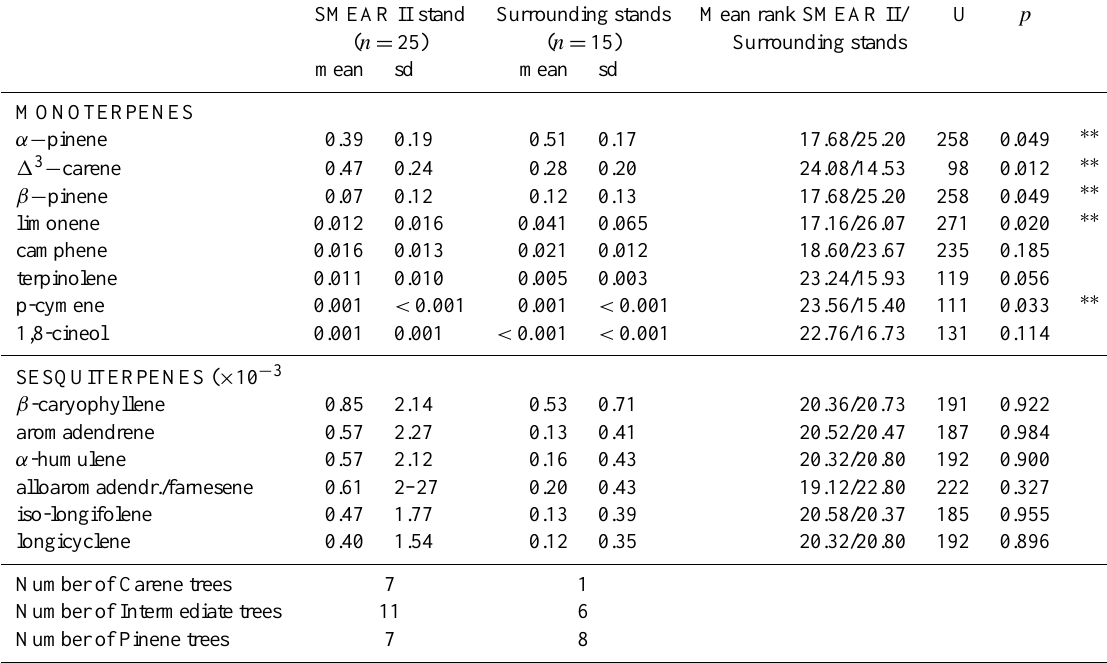
Table 3. Means and standard deviations of proportions of all measured monoterpenes and sesquiterpenes from trees at the SMEAR II stand and at surrounding stands. Results of the Mann-Whitney U-tests for the proportions of different compounds. Statistically significant differences ( p < 0 . 05) between the SMEAR II stand and surrounding stands are marked with ∗∗ . Number of trees in each cluster at SMEAR II stand and surrounding